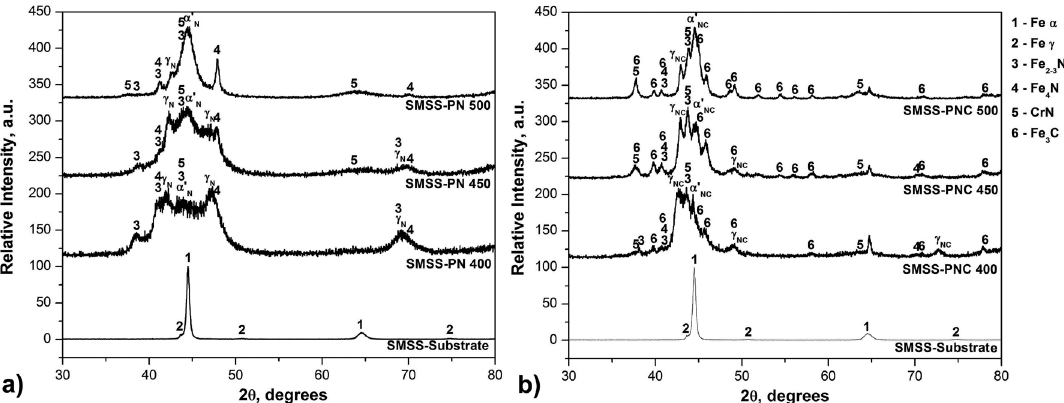
For nitriding (Fig. 2a) very broad and overlapped peaks are detected in the 2θ range from 39 to 49° and additionally at around 69°. Increasing nitriding temperature appears to develop a more crystalline-like diffraction pattern. Broad diffraction lines at low temperatures is most likely a result of the production of expanded phases such as expanded austenite (γ ) and expanded martensite (α' ). Expanded N N austenite is possibly generated in two ways, i.e. upon nitriding of retained austenite and converted from martensite due to the austenite-stabilizing character of nitrogen 20,23